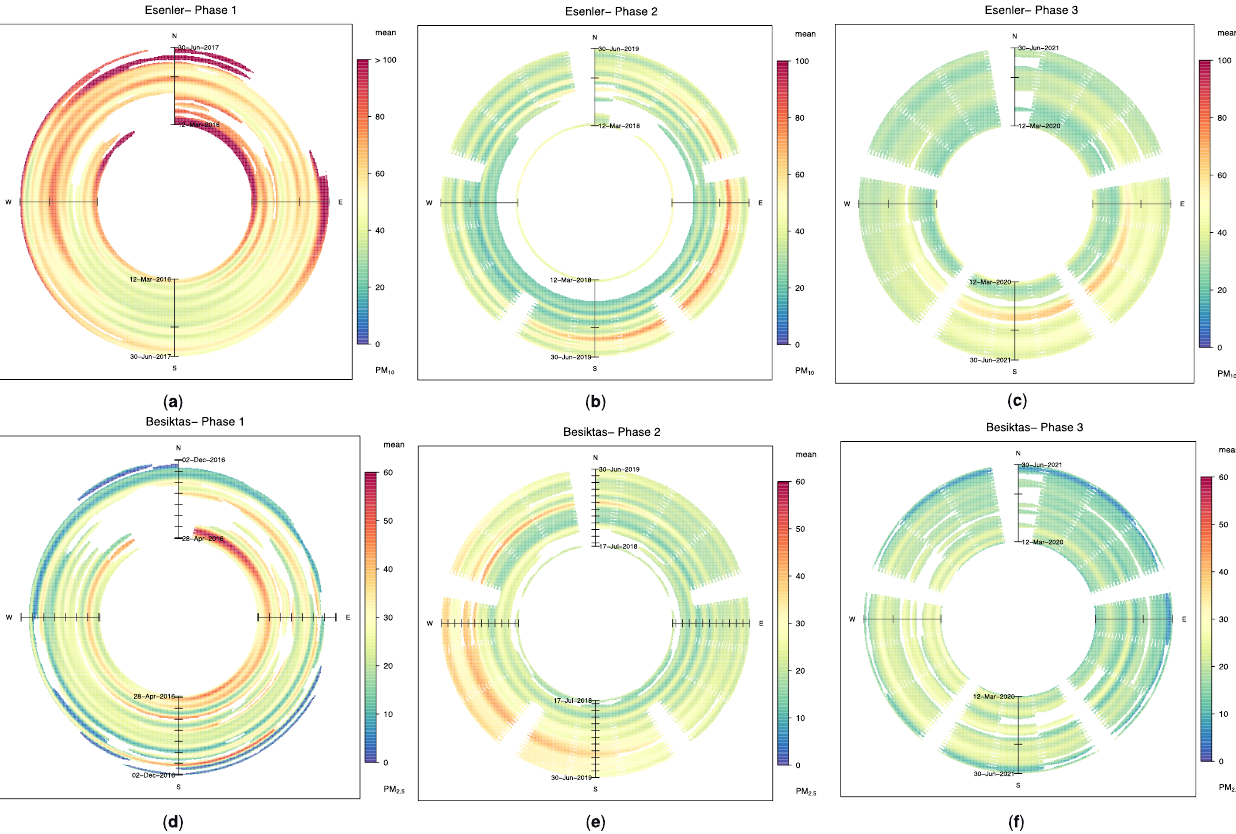
Figure 3. Directional trends of PM 10 ( μ g/m 3 ) and PM 2.5 ( μ g/m 3 ) for Esenler and Besiktas stations, respectively: ( a ) Esenler station PM 10 ( μ g/m 3 ) trends for Phase I; ( b ) Esenler station PM 10 ( μ g/m 3 ) trends for Phase II; ( c ) Esenler station PM 10 ( μ g/m 3 ) trends for Phase III; ( d ) Besiktas station PM 2.5 ( μ g/m 3 ) trends for Phase I; ( e ) Besiktas station PM 2.5 ( μ g/m 3 ) trends for Phase II; ( f ) Besiktas station PM 2.5 ( μ g/m 3 ) trends for Phase III.